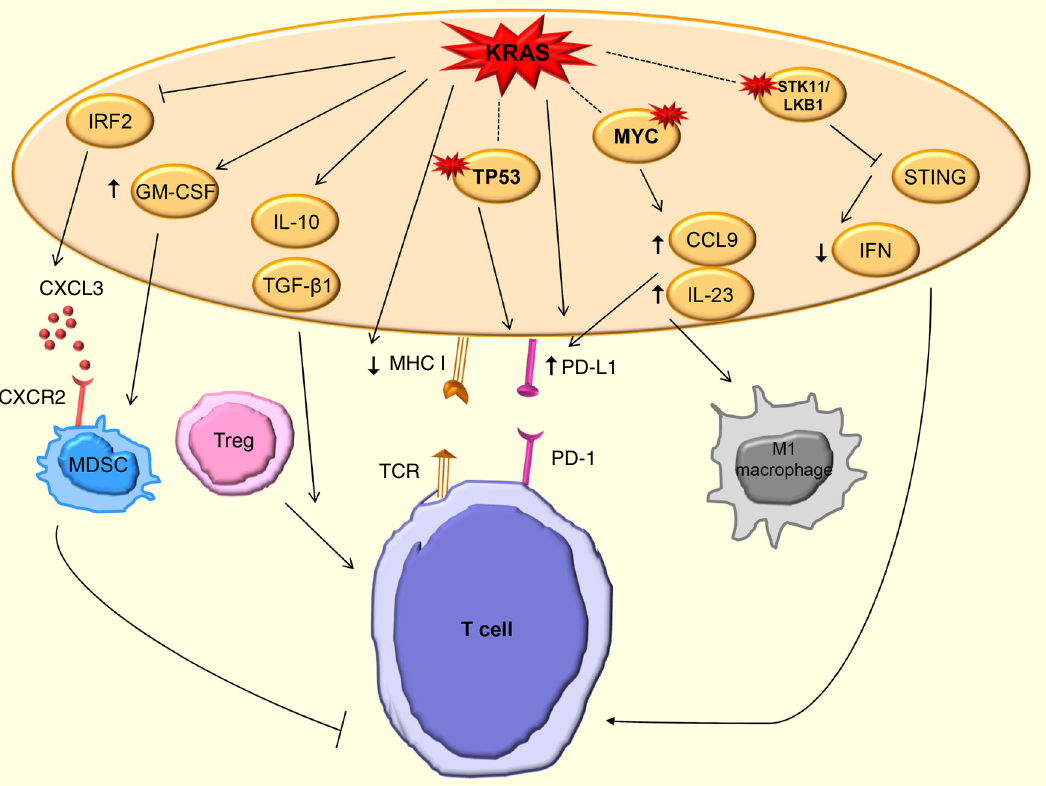
Fig. 2 Effects of KRAS-induced immune modulation in cancer. Multiple intracellular downstream effects of KRAS on chemokine production (CXCL3), cytokine production, MHC expression and ligand expression are shown. Mutations are indicated by a red star symbol (activating mutations in MYC, inactivating mutations in TP53 and STK11/LKB1). The dotted line indicates co-occurring